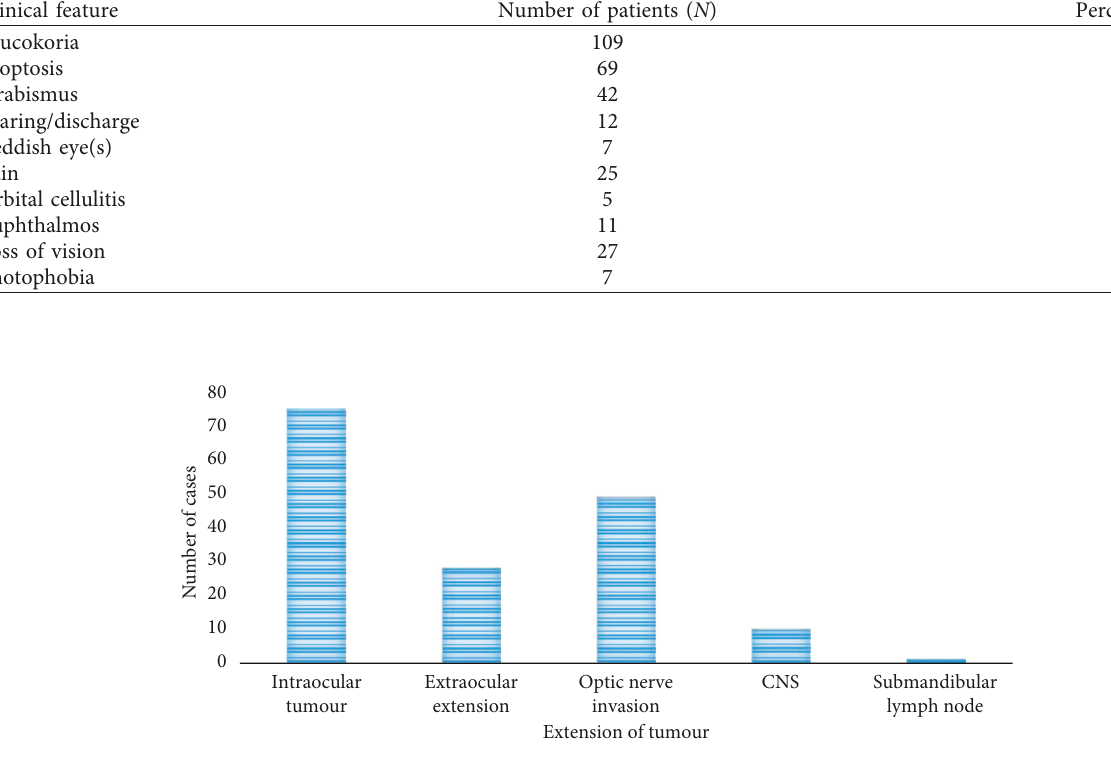
Figure 2: Distribution of the patients by extension of retinoblastoma tumour. Table 3: Histological features of the patients ( n � 234 eyes).